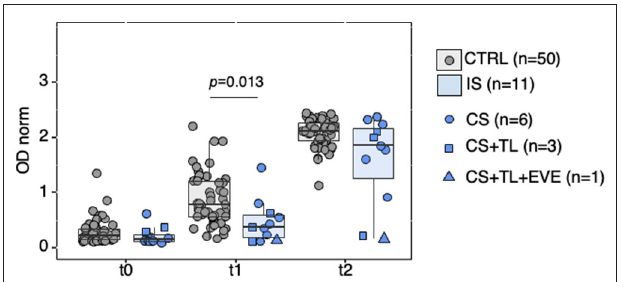
FIGURE 4 | Anti-SARS-CoV-2-spike IgG reactivity in HD patients under immunosuppressive therapy. Partitioning of data presented in Figure 3 , showing HD patients treated with immunosuppressive drugs (IS, n = 11) or not (CTRL, n = 50). Data points represent individual subjects and are overlaid with boxes representing interquartile range (IQR), whiskers representing 1.5 IQR tails, and a central line representing median value. At each time point differences in antibody levels between groups were determined with the Wilcoxon rank sum test (with continuity correction); significant p- values indicated in the figure. IS, immunosuppressive drugs; CTRL, controls; CS, corticosteroids; TL, Tacrolimus; EVE, Everolimus. Detailed p- values presented in Supplementary Table 9 . t0, sera collected on the day of first vaccine dose; t1, sera collected 21 days post-first vaccine dose; t2, sera collected 42 days post-first vaccine